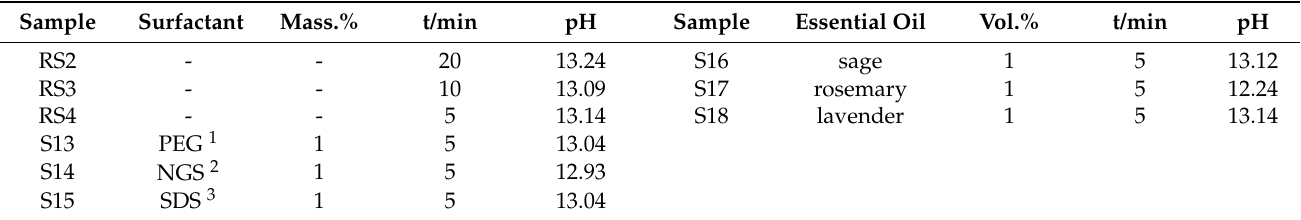
Table 2. Experimental conditions for the samples prepared at 260 ◦ C with different synthesis